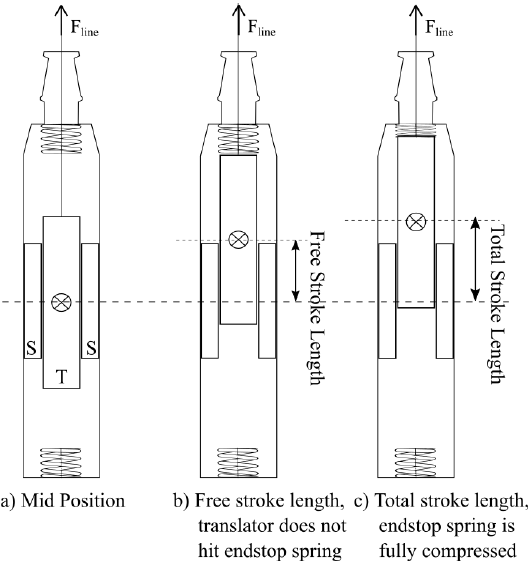
Figure 6. Uppsala University WEC; schematic view of the direct-driven linear generator adapted from [47] under the Creative Commons CC-BY license.